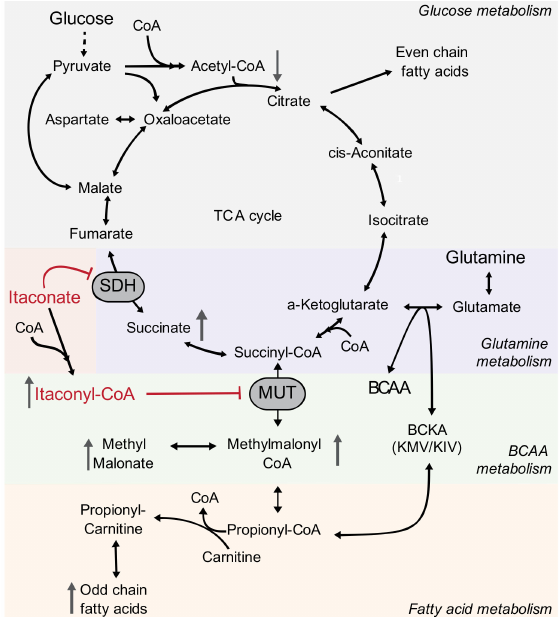
Figure 6. Metabolic compensation induced by itaconate metabolism. Schematic depicts the impact of itaconate metabolism on glucose, glutamine, branched-chain amino acid (BCAA), CoA species, and fatty acid metabolism in mammalian